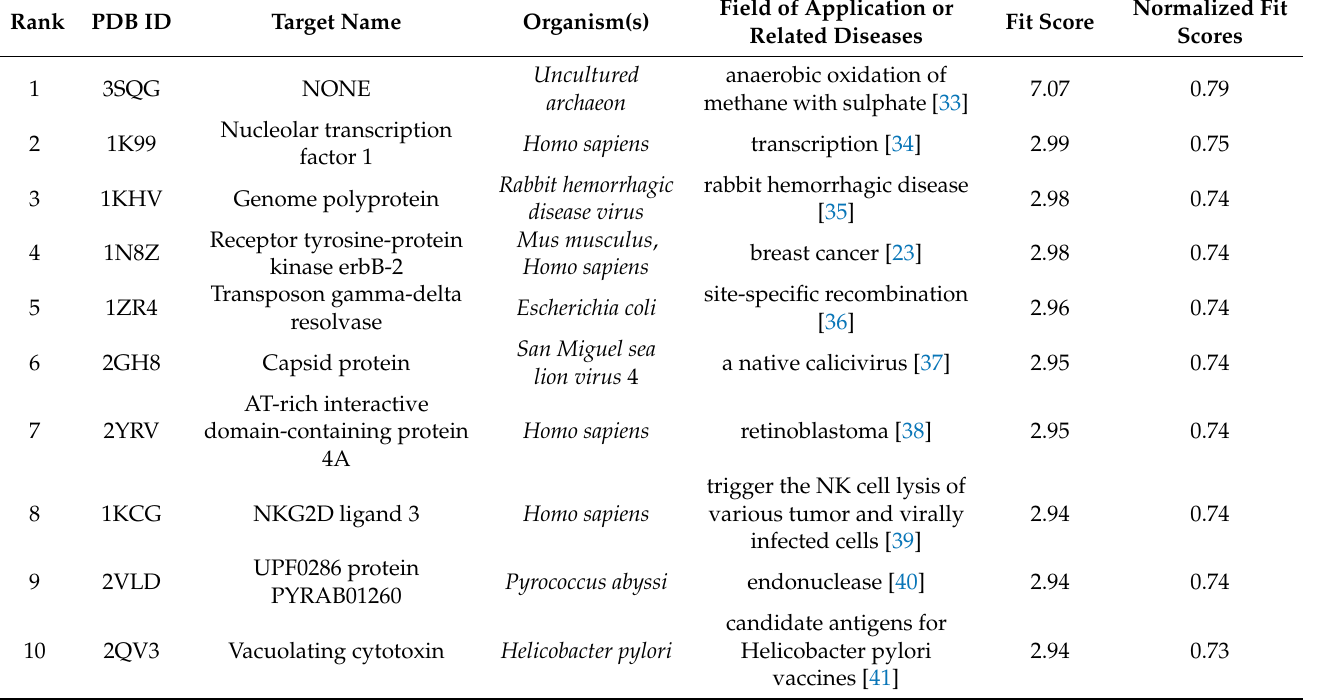
Table 4. Top 10 targets of protein No. 7 and their